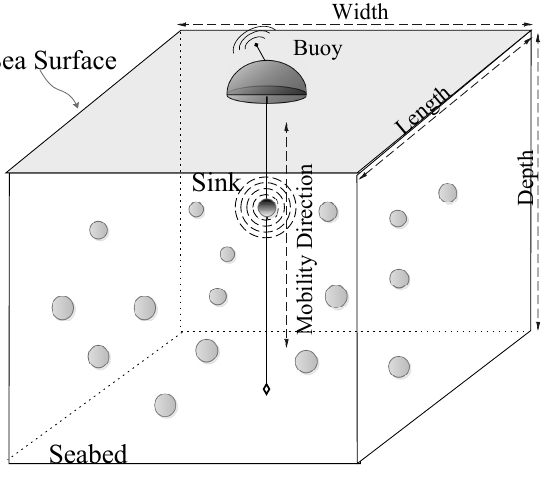
Figure 4. Mobile sink network